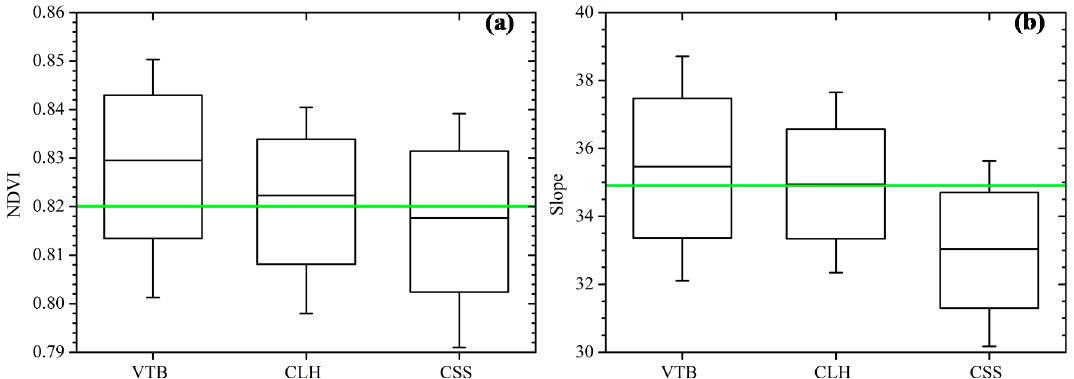
Figure 6. Box plots of the averages of NDVI ( a ) and slope ( b ) calculated from 1000 samples generated using vegetation type-based (VTB), cost-constrained (CSS), and conditioned Latin hypercube without cost constraints (CLH) sampling strategies, respectively. The box stretches from the average + SD to average − SD. The median is shown as a horizontal line in each box. The bars correspond to the 5th percentile and 95th percentile, respectively. The green solid line represents the average calculated from the entire study area.